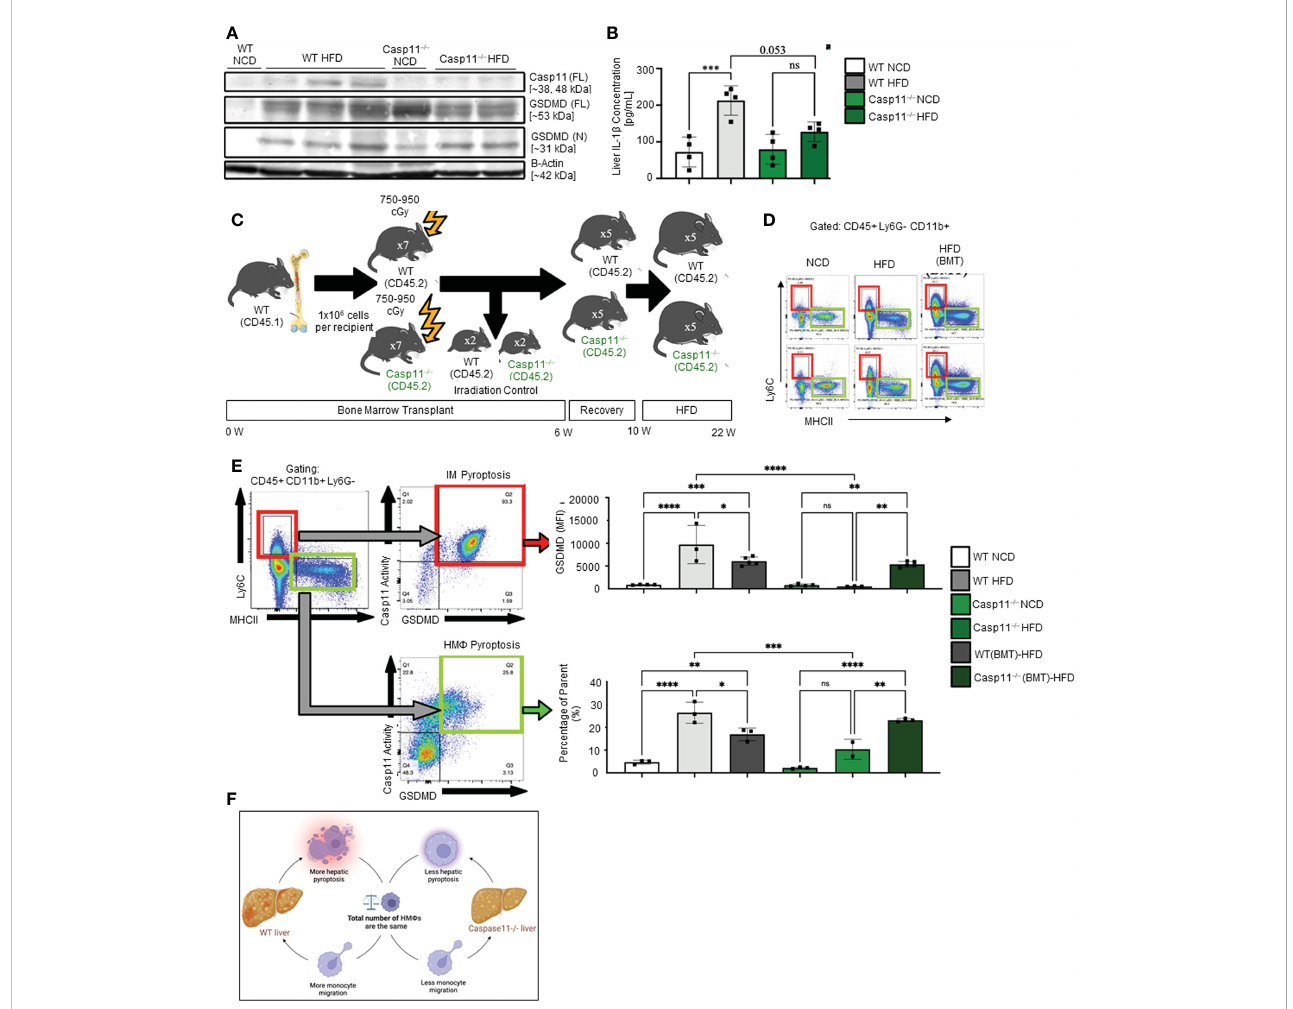
FIGURE 4 Hepatic in fl ammatory monocyte (IM) and monocyte-derived macrophage (MDM) caspase-11 de fi ciency protective against pyroptosis, WT bone marrow transplantation to Casp11 – / – mice restored IM and MDM pyroptosis. 8-10 weeks old male WT and Casp11 – / – mice were fed HFD for 12 weeks. (A) Western blot for noncanonical pyroptosis mediators. (B) Liver IL-1 b concentrations. (C) Experimental design for bone marrow transplantation (BMT). (D) Representative fl ow cytometry gating of hepatic macrophages (HM F , Green, CD45+ > CD11b+ Ly6G- > Ly6Clow MHCIIhigh) in fl ammatory monocytes (IM, Red, CD45+ > CD11b+ Ly6G- > Ly6Chigh MHCIIlow). (E) Gating strategy for designing pyroptosis populations. HM F s and IMs gated on GSDMD MFI vs. Casp11-Inhibitor MFI. RED: GSDMD MFI for IM (CD45+ > CD11b+ Ly6G- > Ly6Chigh MHCIIlow). GREEN: Percentage of the parent for HM F pyroptosis gating CD45+ > CD11b+ Ly6G- > Ly6Chigh MHCIIlow > Casp11 Activity vs GSDMD). (F) Schematic diagram showed that WT mice had more monocyte migration and more hepatic pyroptosis, however, Casp11 – / – had less monocyte migration and hepatic pyroptosis resulting in an unchanged total number of hepatic macrophages. Statistical Analysis: Flow cytometry data was analyzed with FlowJo, and statistical analysis was performed using Prism. One-Way ANOVA. One-Way ANOVA. *p < 0.05, **p < 0.001, ***p < 0.0001 ****p < 0.0001. ns, Non-signi fi